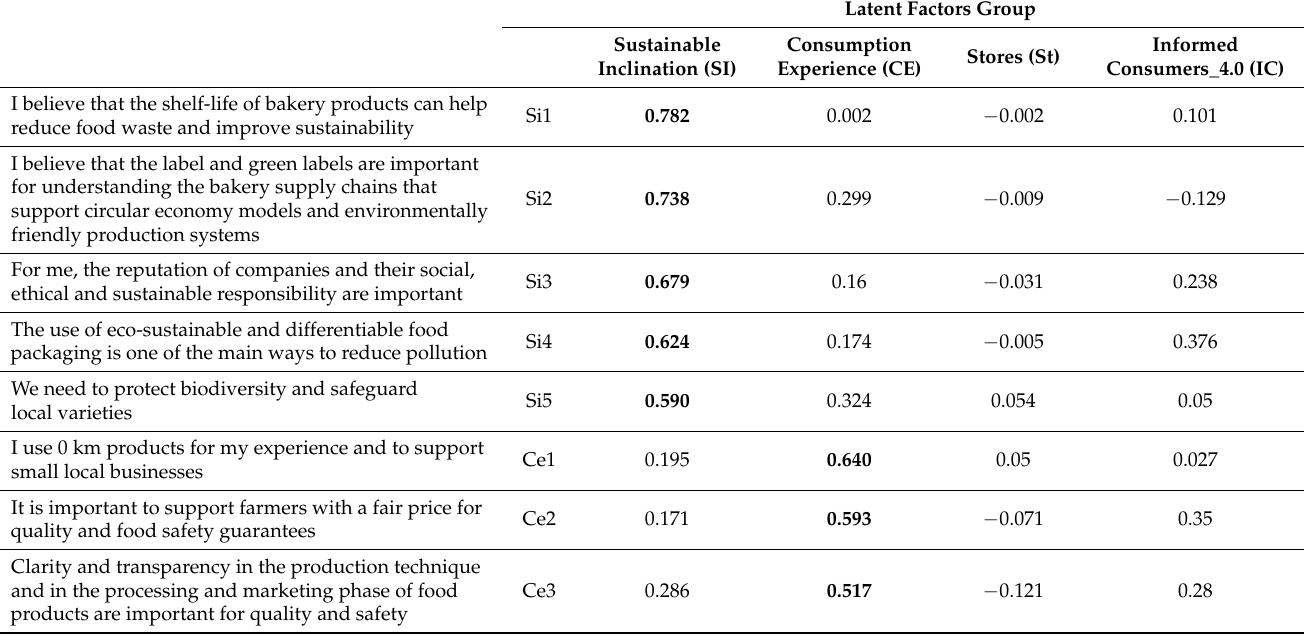
Table 3. Factorial analysis Rotated Component Matrix a